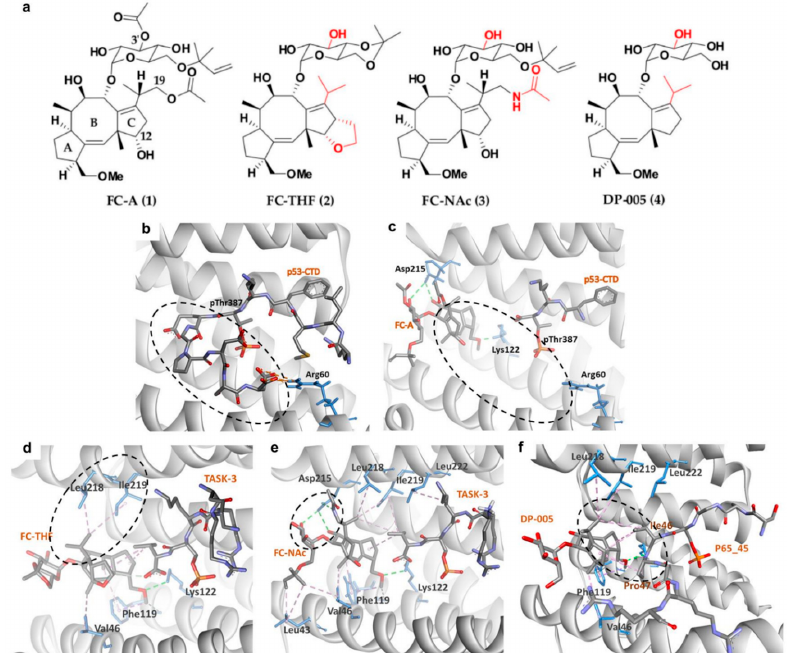
Figure 4. ( a ) Chemical structure of common fusicoccanes stabilizers of 14-3-3 σ PPI with the modified groups from compound 1 in red. Three-dimensional (3D) crystal structure of P53/14-3-3 σ complex ( b ) in the absence of FC-A (PDB: 5MOC) and ( c ) in the presence of FC-A (PDB: 5MXO), revealed that the C-terminus of the P53 peptide cannot be observed upon binding of FC-A (dashed circles). 3D complex of 14-3-3 σ / TASK-3 with ( d ) FC-THF (PDB: 3SMN) and ( e ) FC-NAc (PDB: 6GHP) revealed hydrophobic (purple dashed lines) and hydrogen bond (green dashed lines) interactions between 14-3-3 σ and the isopropyl or 19-acetamide moiety of FC-THF and FC-NAc, respectively (dashed circles). ( f ) 14-3-3 σ / DP-005 / p65_45R ternary complex (PDB: 6NV2) showed that DP-005 not only forms hydrophobic interactions (purple dashed lines) with 14-3-3 σ , but also with P65_45 (dashed